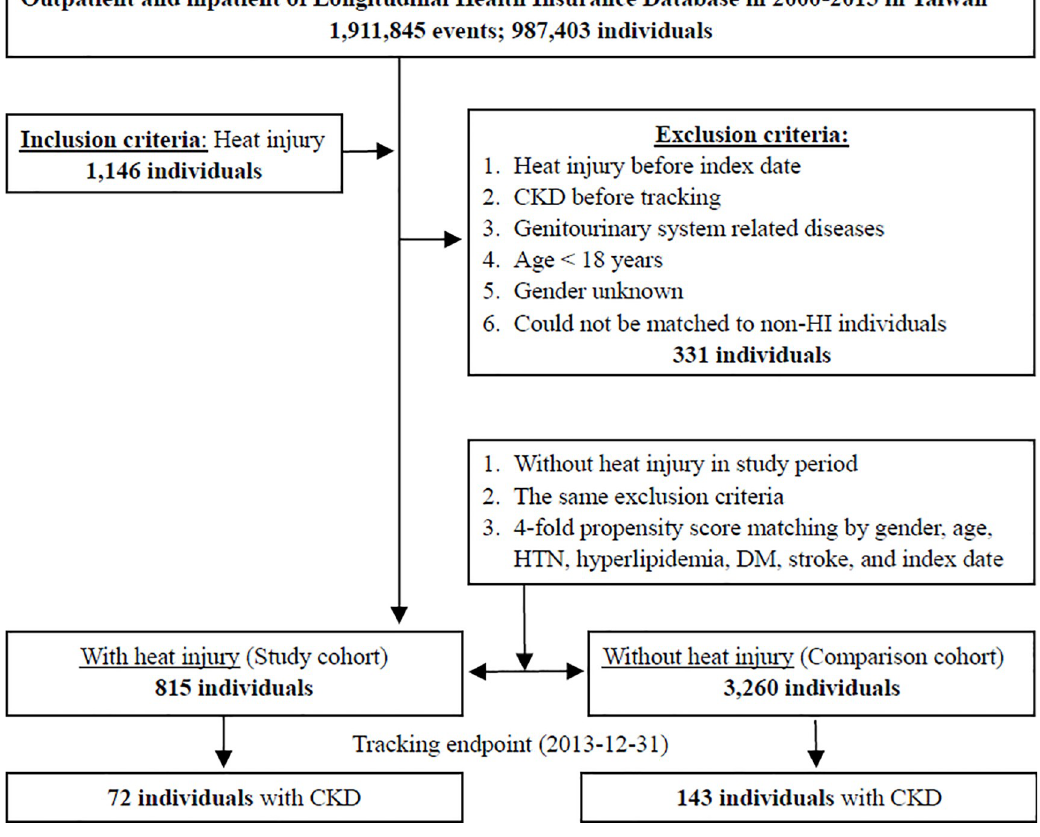
Fig 1. Patient selection flow chart. CKD: Chronic kidney